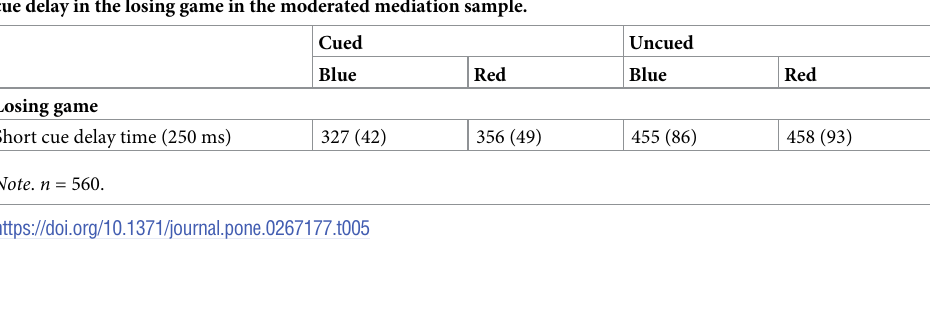
cues signaling non-punishment with both short ( r = . 15 , p = . 084 , BF01 = 1 . 64) and long cue delay ( r = . 09 , p = . 208 , BF01 = 3 . 49) . The Bayes factors indicated anecdotal/weak to moderate